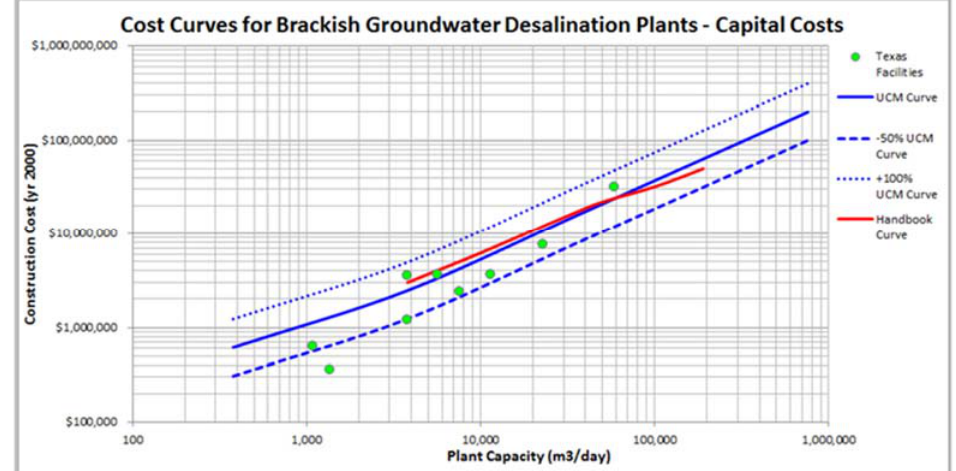
Figure 7. Comparison of the CAPEX costs for nine BWRO plants in Texas to the cost curves developed by Unified Costing Model [53] and the Desalting Handbook for Planners [33]. This cost model has not been corrected for the consumer cost increase from when the model was created to the current cost.